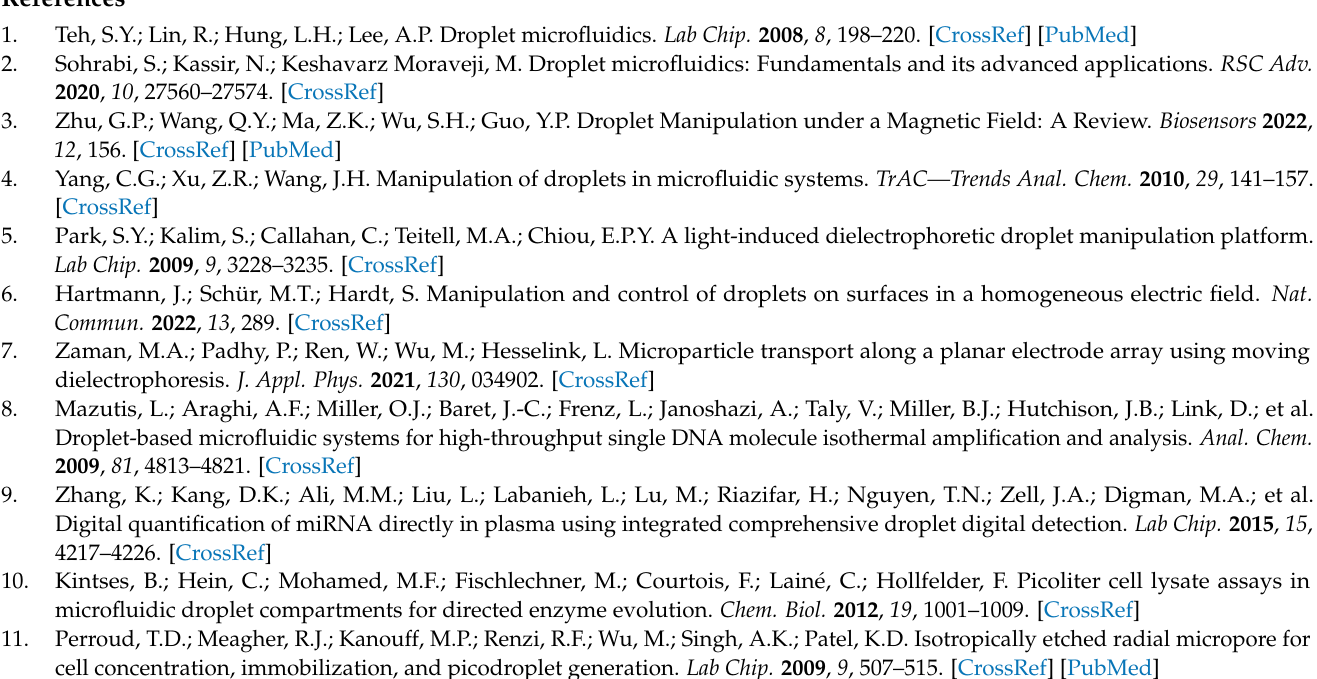
Cartridges. Figure S1: (A) Tube connecting syringe containing bead suspension to the droplet gener- ation cartridge; red arrow shows region of bead sedimentation. (B) Syringe design for mechanical resuspension and homogenization of dense particles for vertical delivery. The DC motor is powered using a 3V battery. Figure S2: Without the syringe mixer in Figure S1, bead sedimentation happens in the syringe and tubing, leading to the encapsulation of multiple beads per droplet. Figure S3: Denser fluids, such as glycerol, may improve bead buoyancy but it inhibits LAMP amplification (blue trace vs. red trace). Bead Density = 1.18 g/ cm 3 , Glycerol Density = 1.26 g/cm 3 . Figure S4: Microcapillary lines imprinted by 3D printed mold. This is often due to printer-head misalignment that often occurred during prolonged prints. Figure S5: Micrograph showing curved vertices imprinted from 3D-printed mold. Figure S6: Irregularities in chamber dimensions due to myriad factors, including incompletely cured PDMS and build-up PDMS deposit due to mold reuse. Note that the displayed images contain channels designed to have widths of 50 and 100 µ m. Figure S7: Frosted PDMS molded on improperly cleaned 3D printed mold. Figure S8: Image of final fabricated PDMS device and 3D printed